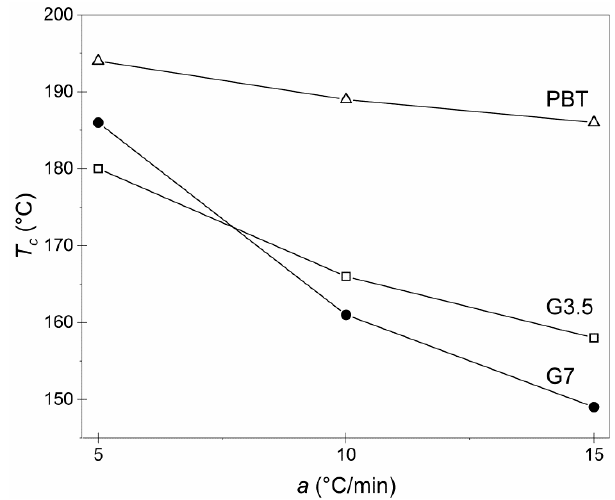
Figure 3. T c at each cooling rate of neat PBT and vitrimers G3.5 and G7 all three produced at the optimum SSP conditions (180 °C, 3 h).